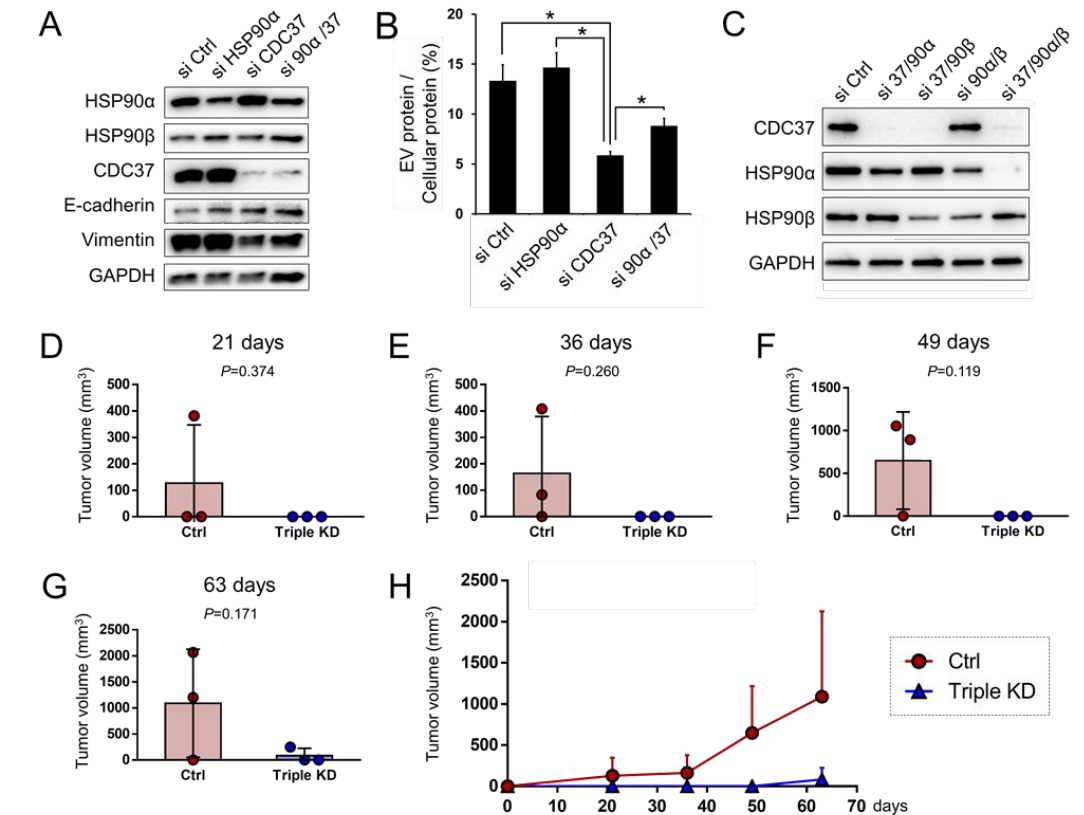
Figure 6. EMT properties, vesicle release, and tumorigenicity were declined by targeting CDC37 and HSP90. ( A , B ) PC-3 cells were transfected with siRNA targeting CDC37, HSP90 α , their combination, or non-targeting control siRNA for 48 h and then cell lysates and EVs were collected. ( A ) Western blot showing CDC37, vimentin, E-cadherin, HSP90, and GAPDH. ( B ) The ratio of EV vs. cellular protein concentrations. * p < 0.05, n = 3. ( C ) Western blot showing CDC37 and HSP90 reduced by double or triple knockdown. siRNA targeting CDC37, HSP90 α , and HSP90 β or non-targeting control siRNA were transfected into PC-3 cells and then cells were lysed at 48 h post-transfection. E ffi ciencies of double or triple knockdown were tested. ( D – H ) In vivo tumorigenesis declined by triple chaperone knockdown. PC-3 cells were transfected with triple siRNA combination (CDC37, HSP90 α , HSP90 β ) or non-targeting control siRNA and then cells were subcutaneously xenografted to SCID mice. Tumor volumes at ( D ) day 21, ( E ) day 36, ( F ) day 49, and ( G ) day 63 post-xenograft periods were analyzed by scatter-plotting. Data are expressed as mean ± SD, n = 3. ( H ) The time-course graph of tumor volumes altered between triple chaperone knockdown vs. the control siRNA groups. Data are expressed as mean + SD, n = 3.